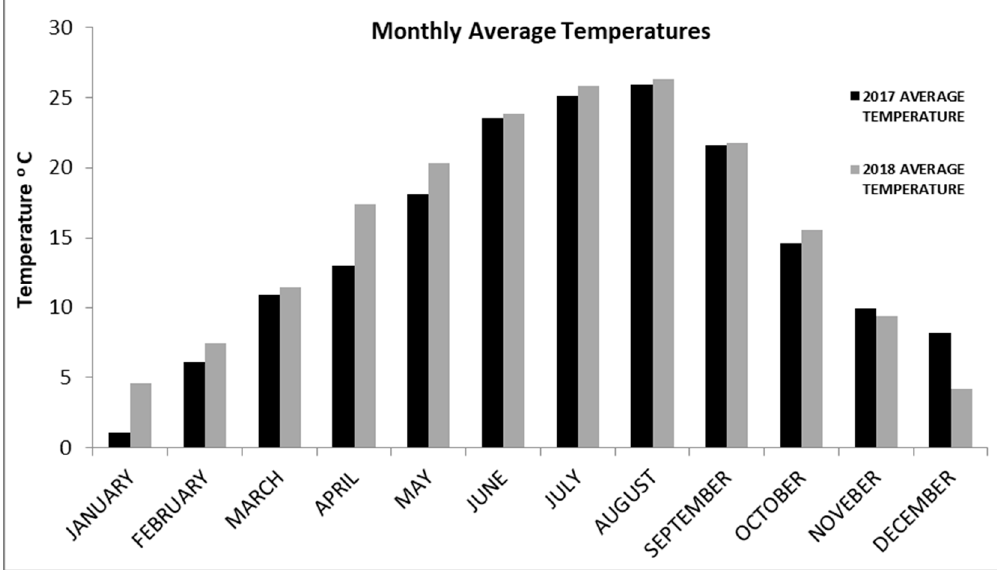
Figure 3. Monthly average temperatures of Soufli area during 2017 and 2018. Table 3. Results from One–Way Analysis of Variance (ANOVA) with Tukey’s test of the conventional wine analysis parameters of the “Karnachalades” and “Bogialamades” must in two consecutive vintages. Variety